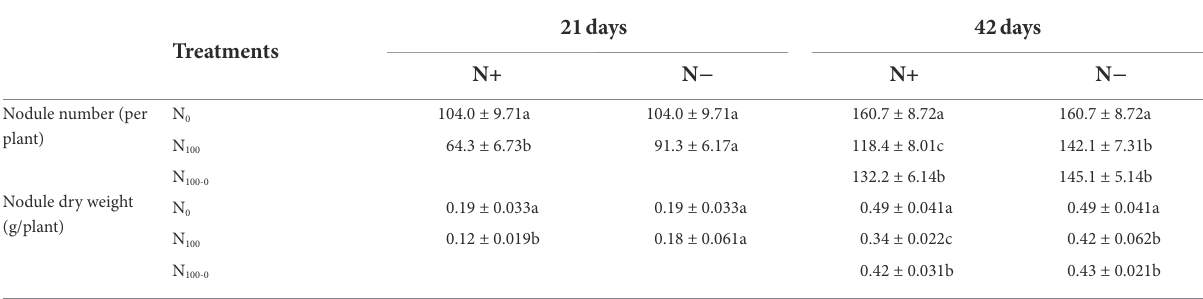
TABLE 1 Changes of dual-root soybean nodules.